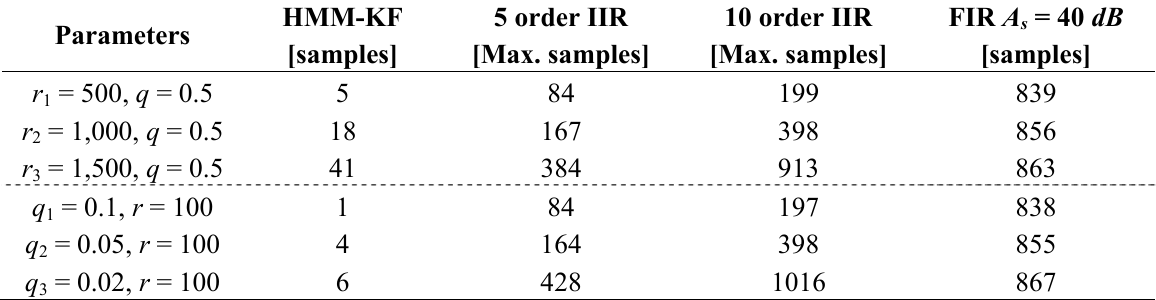
Table 6. Comparison of the time delay (in samples) of the z axis acceleration using the three